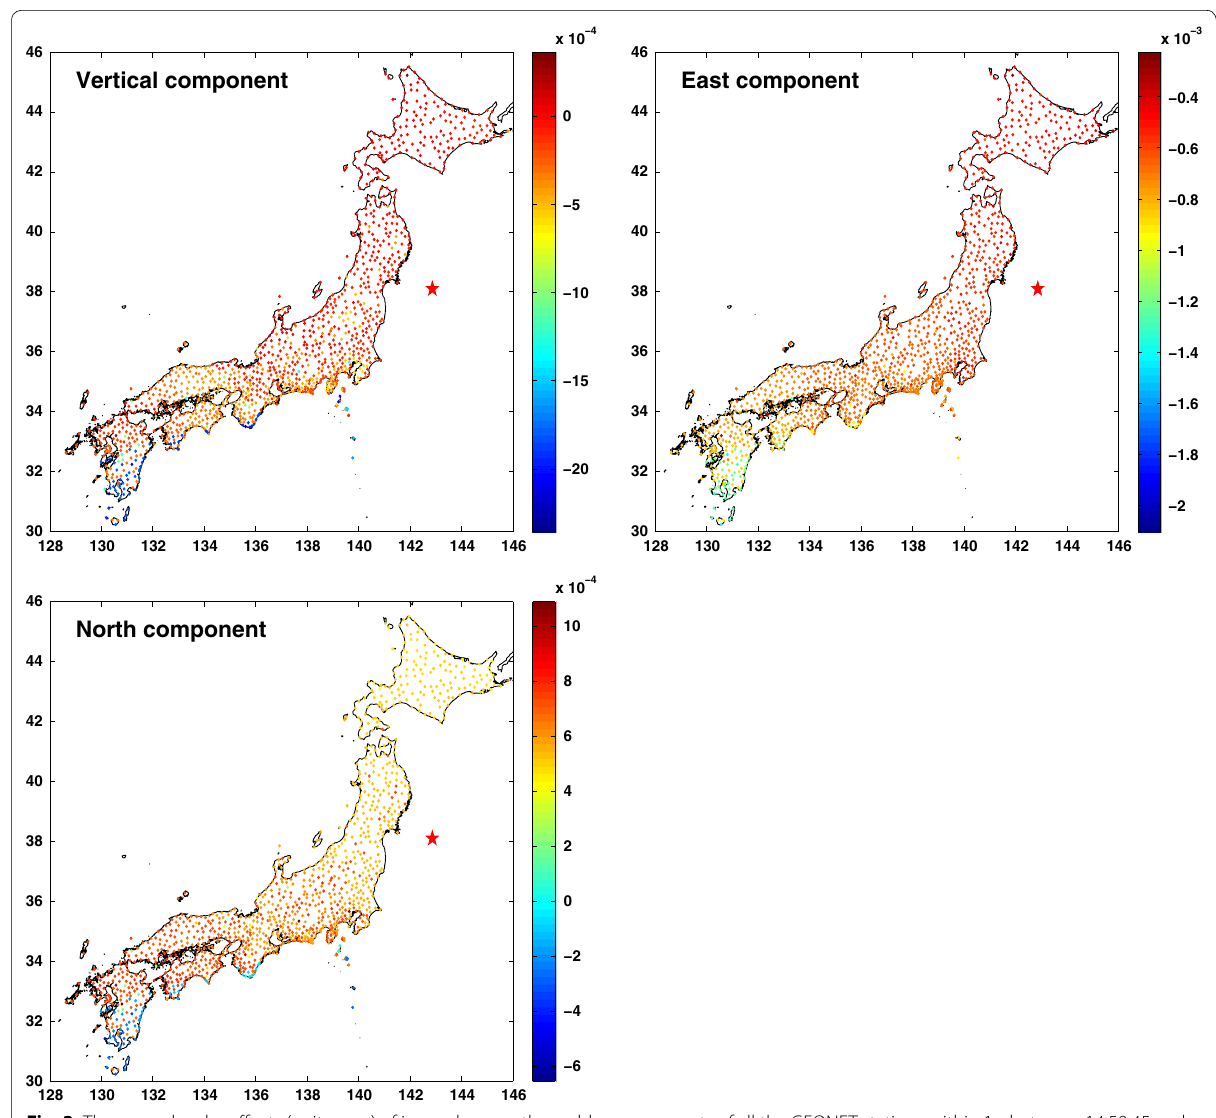
Fig. 3 The second-order effects (units: mm) of ionosphere on the sudden movements of all the GEONET stations within 1 s between 14:59:45 and 14:59:46, corresponding to the vertical, east and north directions, respectively. The red star stands for the epicenter of the 2011 Tohoku earthquake